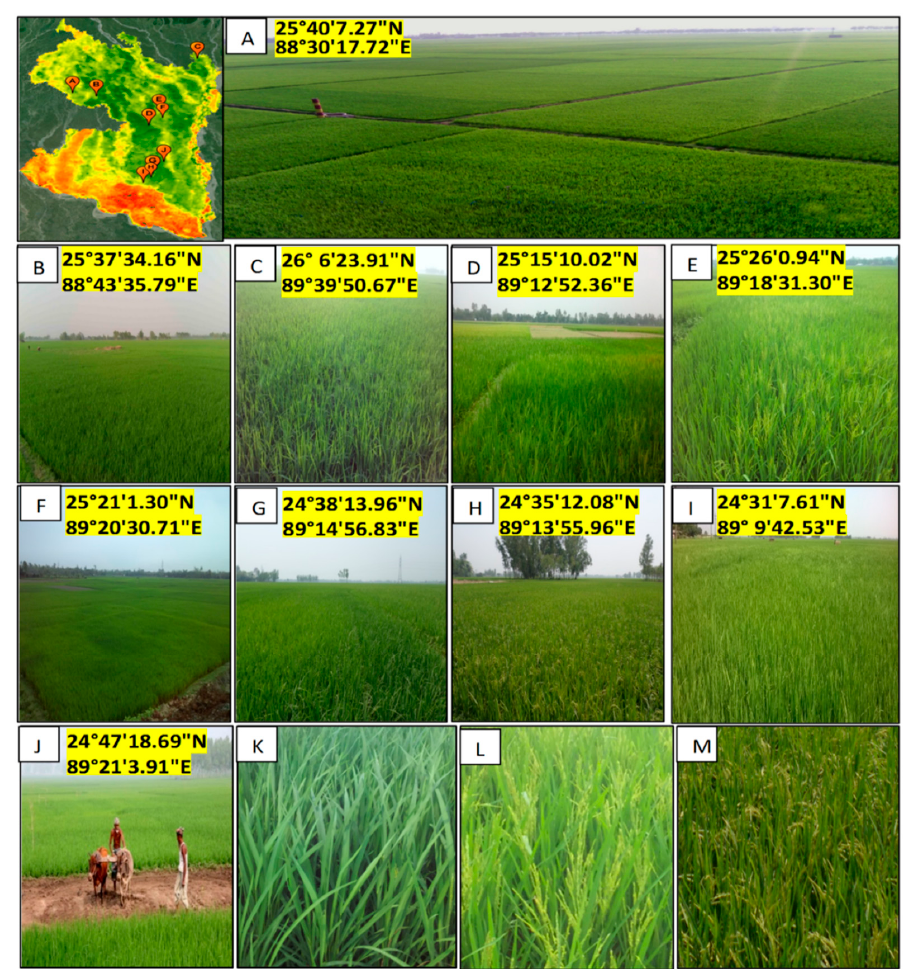
Figure 7. Field observations in lowTVDI area. Booting / heading stage ( K ), flowering and milk stage ( L ), and dough stage ( M ) .